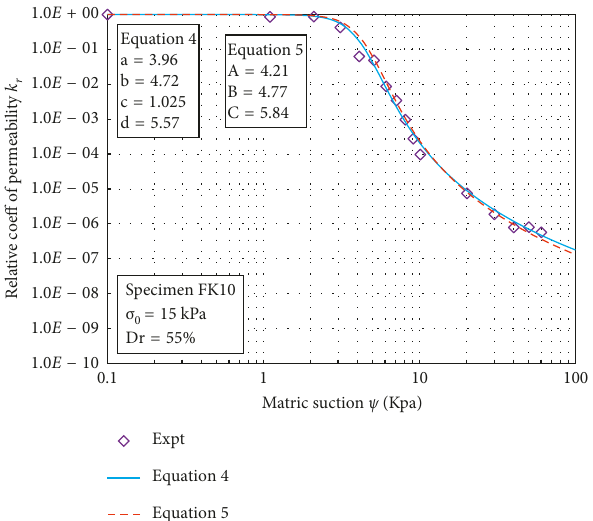
Figure 8: Permeability coefficient changes against matric suction for soil FK30.